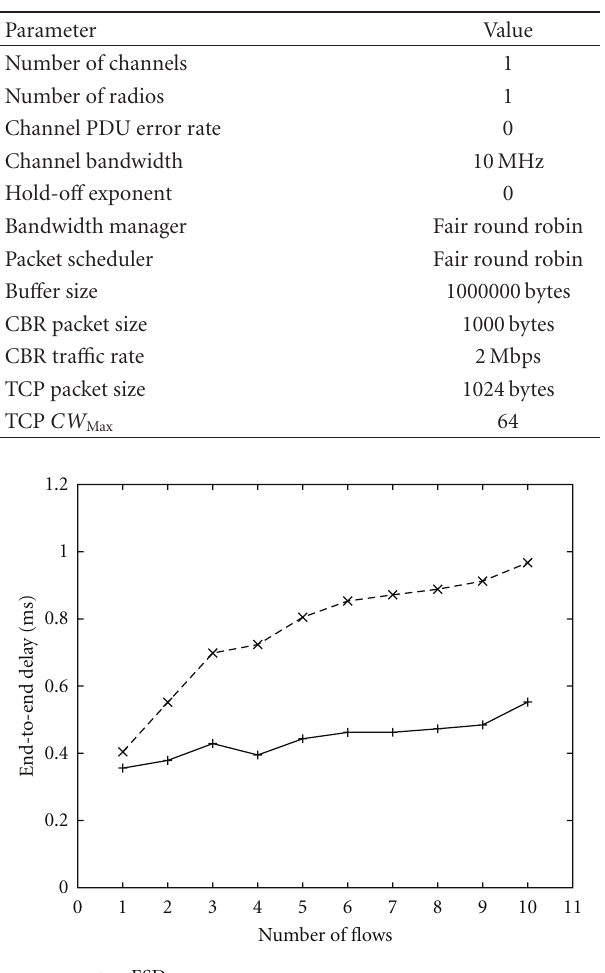
Table 3: Simulation Environment.